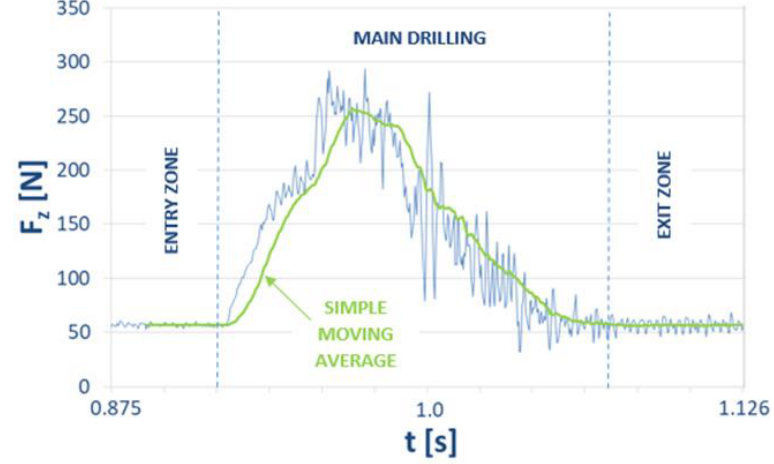
Figure 10. Enlarged fragment of the graph showing the time course of the cutting-force component F z in Figure 9, with a marked course of simple moving average.